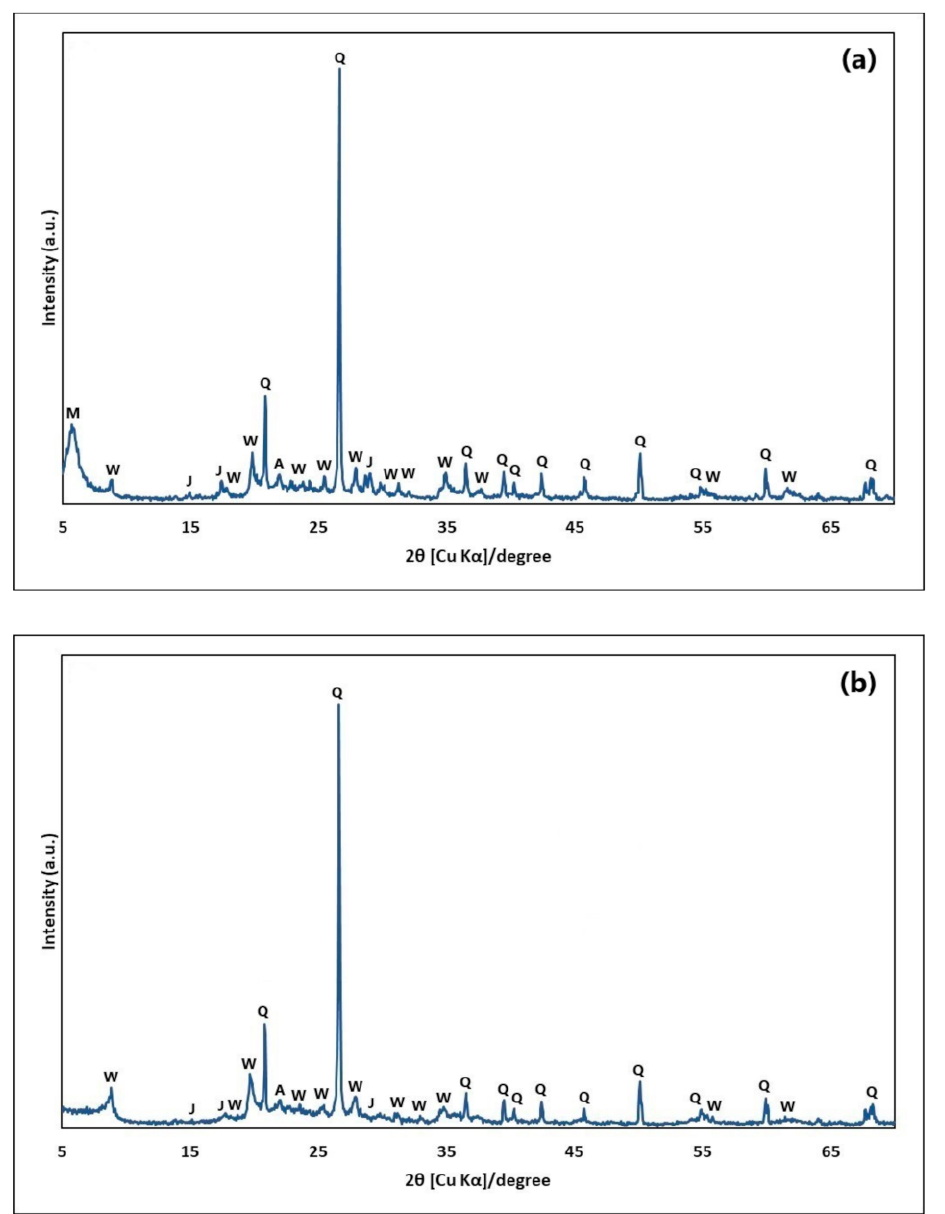
Figure 1. X-ray diffraction (XRD) pattern of diatomaceous earth (DE): ( a ) raw and ( b ) purified. Q: quartz, J: jarosite, A: albite, W: muscovite, M: montmorillonite.